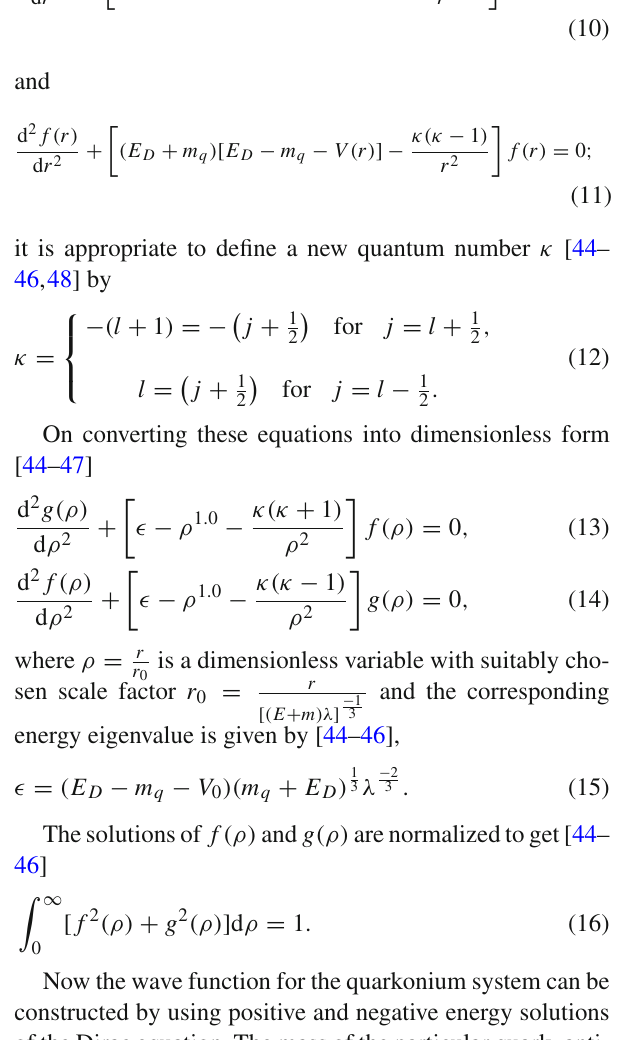
Table 2 Model parameters fitted in our model for the charmonium and bottomonium systems System parameters b ¯ b c ¯ c Quark mass (in GeV/ c 2 ) m